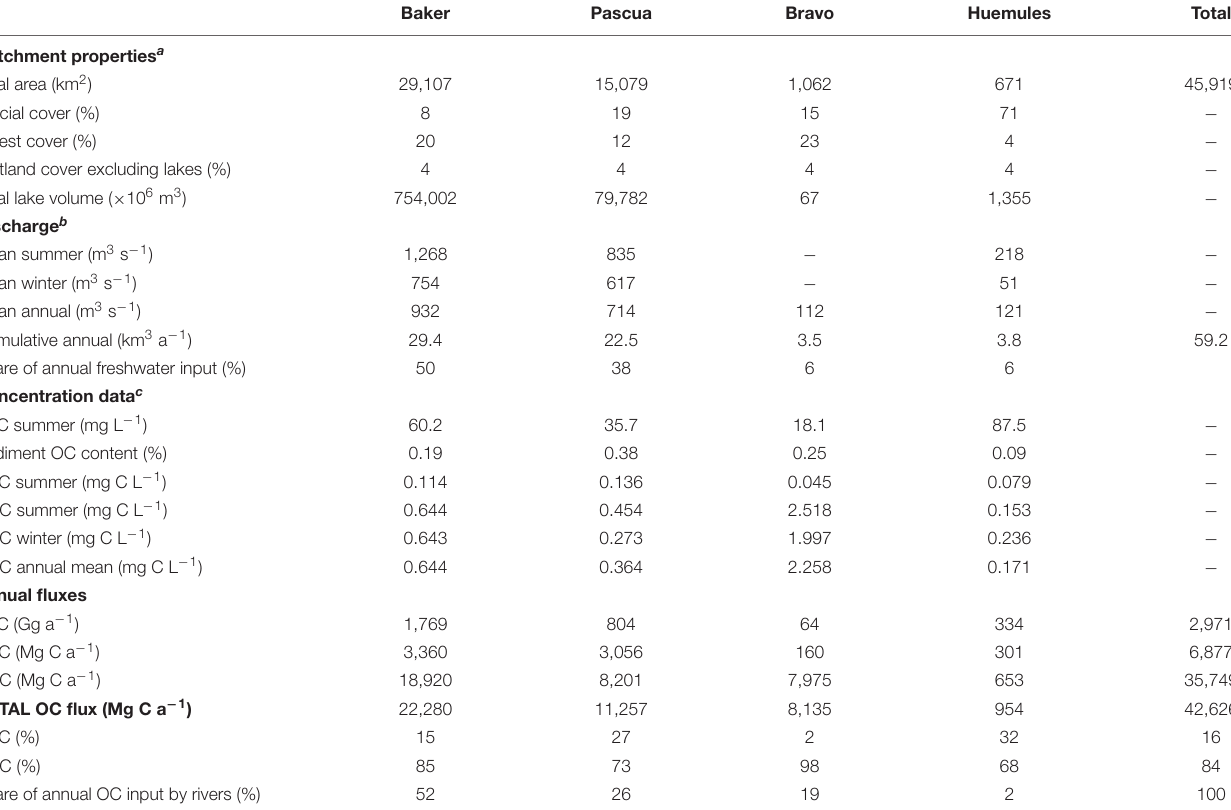
TABLE 4 | Annual freshwater and organic carbon (OC) fluxes from the four principal rivers entering Baker-Martinez Fjord. Baker Pascua Bravo Huemules